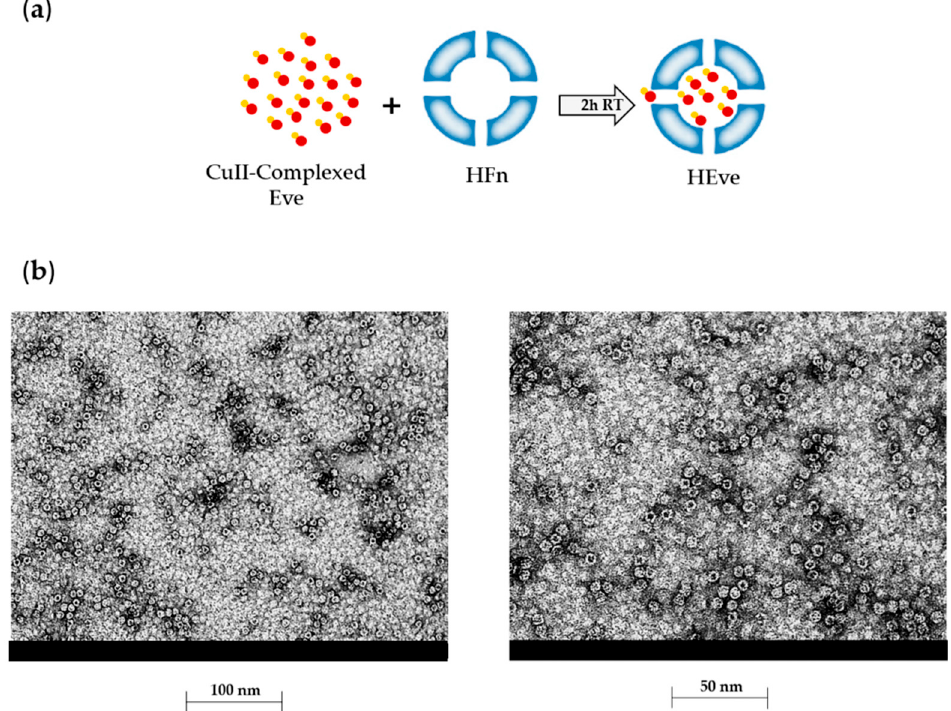
Figure 3. Development and characterization of HEve. ( a ) Schematic representation of the HFn loading strategy used for HEve production. After Everolimus precomplexation with Cu(II), the loading of HFn nanocage with Eve is a metal-driven process. Everolimus is represented in red, with Cu(II) in orange. ( b ) Electron microscopy images of Everolimus-loaded HFn nanoparticles obtained with the Cu(II) precomplexation strategy.